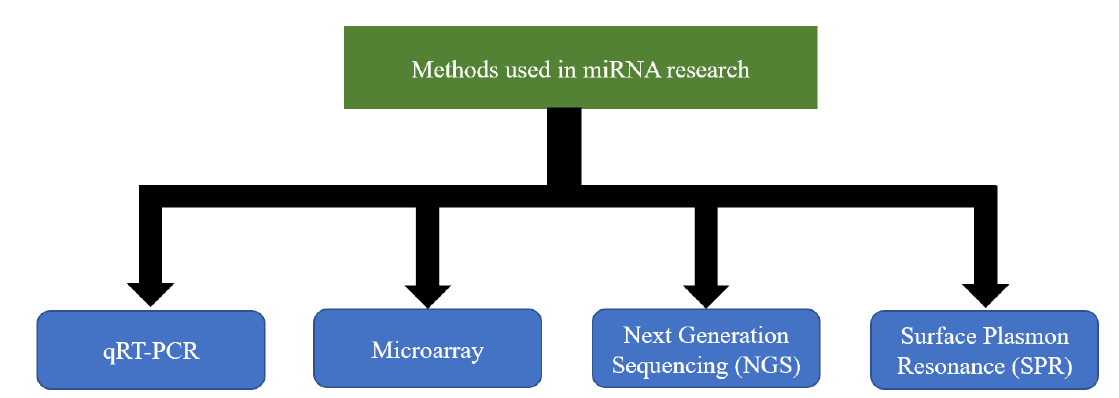
Figure 2. Methods currently used in microRNAs (miRNA) research.